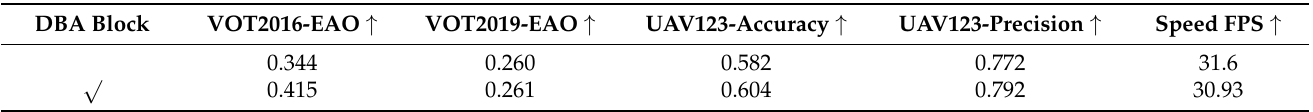
Table 3. A comparison of evaluation results of DBA-Siam without DBA block and DBA-Siam with DBA block on multiple datasets (items with better parameters are marked in red). ↑ indicates that the larger the parameter value, the better the tracker performance. ↓ indicates that the smaller the parameter value, the better the tracker